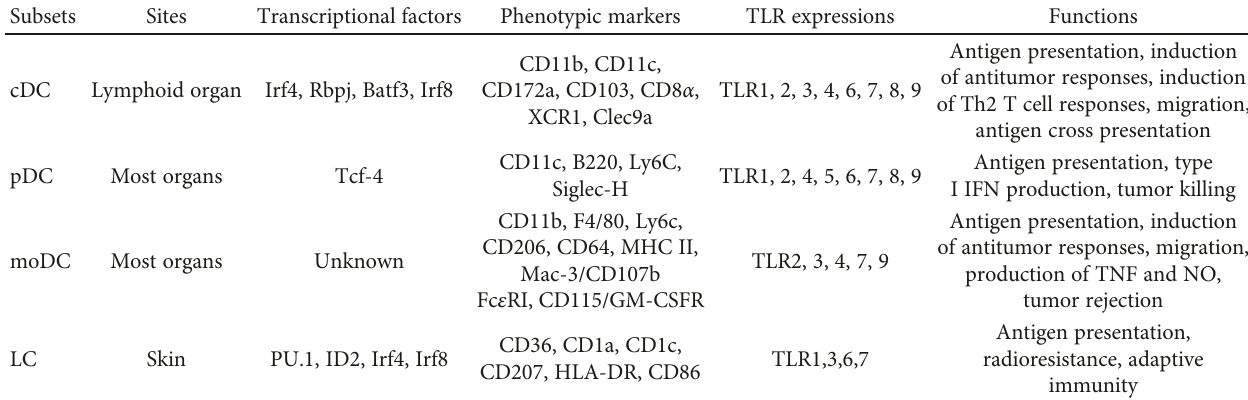
Table 1: DC subsets and their basic functions in